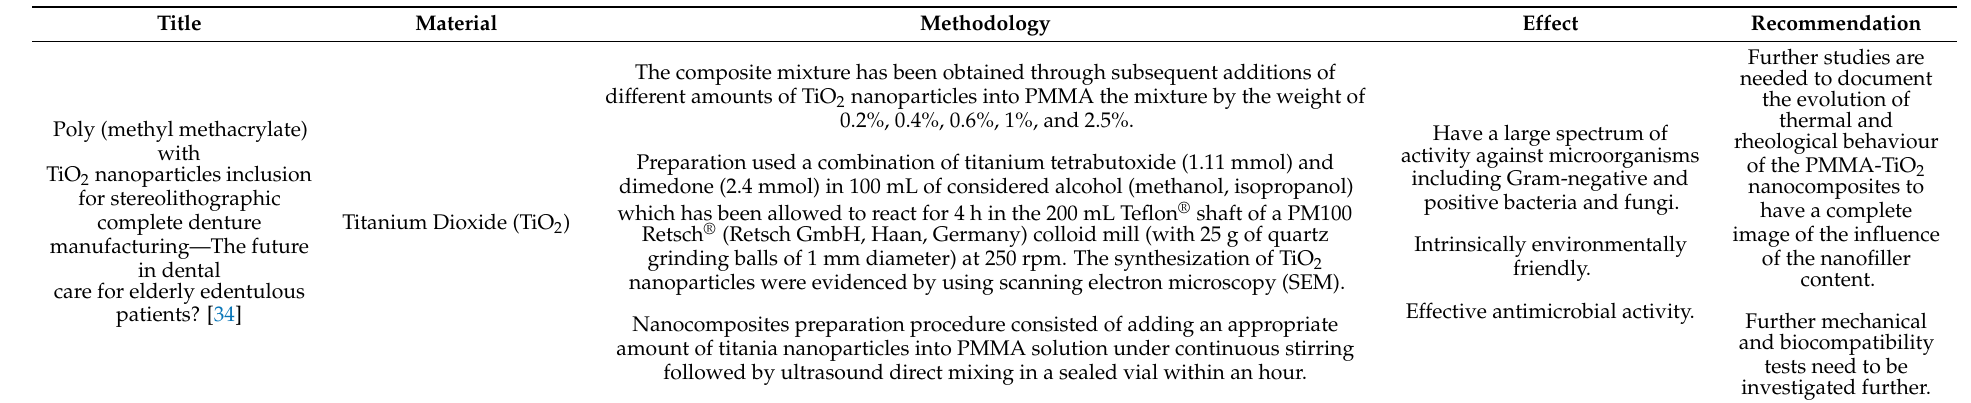
Table 1. Summary on modifications on conventional and digital denture to improve general characteristic properties of the